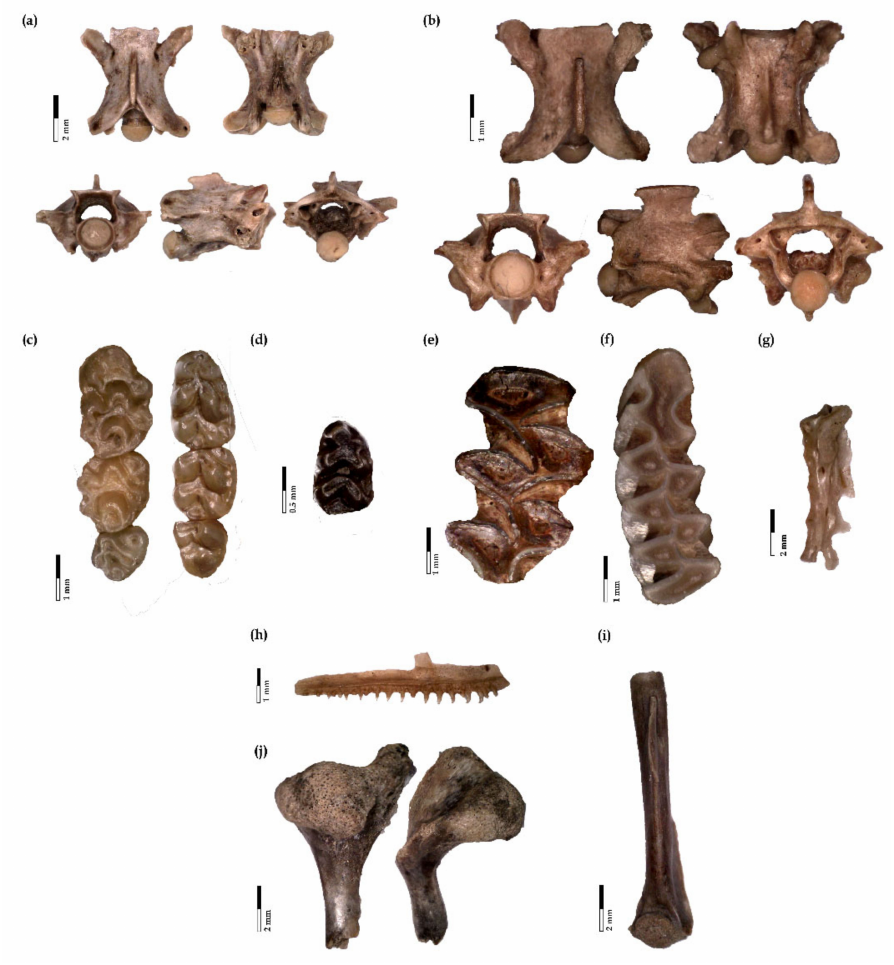
Figure 6. Some examples of microvertebrate from Borsodiv á nka 2020. ( a ) Zamenis longissimus (Probe 6, Layer S1101), trunk vertebra. ( b ) Natrix cf. natrix (Probe 29, Layer S55), trunk vertebra. ( c ) Apodemus sylvaticus , right maxillary (left, Probe 13, Layer S1097), and mandibular tooth rows (right, Probe 16, Layer S1097). ( d ). Mus musculus (Probe 16, Layer S1097), right m1. ( e ) Arvicola amphibius (Probe 48, Layer S1100), left M2. ( f ) Microtus arvalis (Probe 18, Layer 1066), right m1. ( g ) Talpa europaea (Probe 29, Layer S55), lumbar vertebrae region. ( h ) Rana sp. (Probe 16, Layer S1097), right premaxilla. ( i ) Bufo/Bufotes sp. (Probe 42 Layer S7), left humerus of male. ( j ) Emys orbicularis (Probe 44, Layer S7), left humerus in dorsal (left) and lateral (right) views. By element, 1086 fish remains correspond to unidentified elements (19.1%), followed by scales (NISP = 1045, 18.3%), precaudal vertebrae (NISP = 918, 16.1%), spines (NISP = 821, 14.4%), caudal vertebrae (NISP = 700, 12.3%), cranial elements (NISP = 592, 10.4%), ribs (NISP = 319, 5.6%) and fragments of vertebrae (NISP = 221, 3.9%). The relative proportion of species in terms of the estimated number of caught indi- viduals was assessed through NVcor and Nci (Table 5). The results confirm the strong predominance of cyprinids (72.22%), followed by the northern pike ( E. lucius ; 16.67%). The European perch ( P. fluviatilis ; 8.33%) and pikeperch ( S. lucioperca ; 2.78%) are less